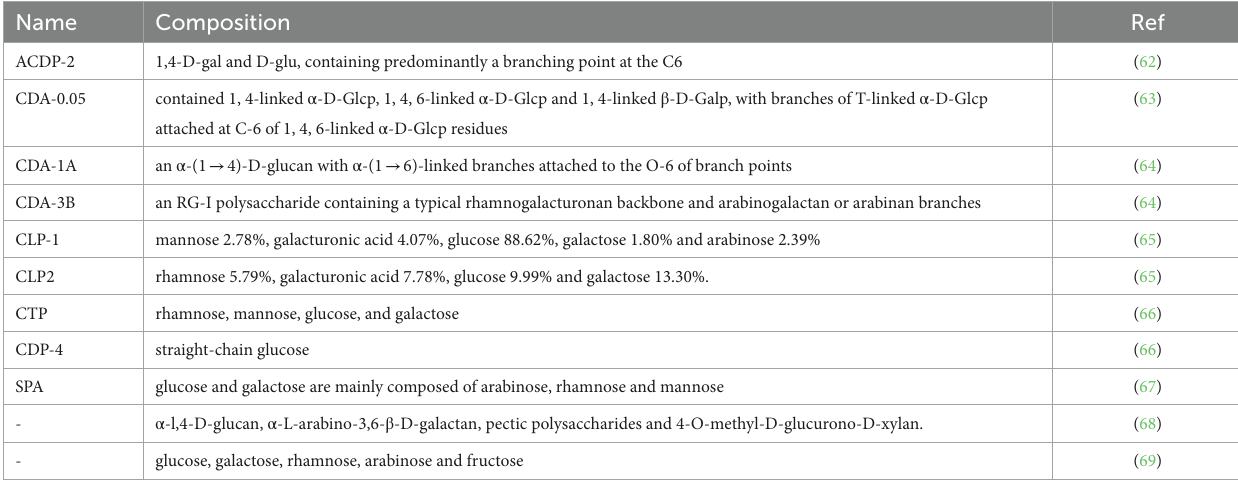
TABLE 6 Other compounds from Cistanche